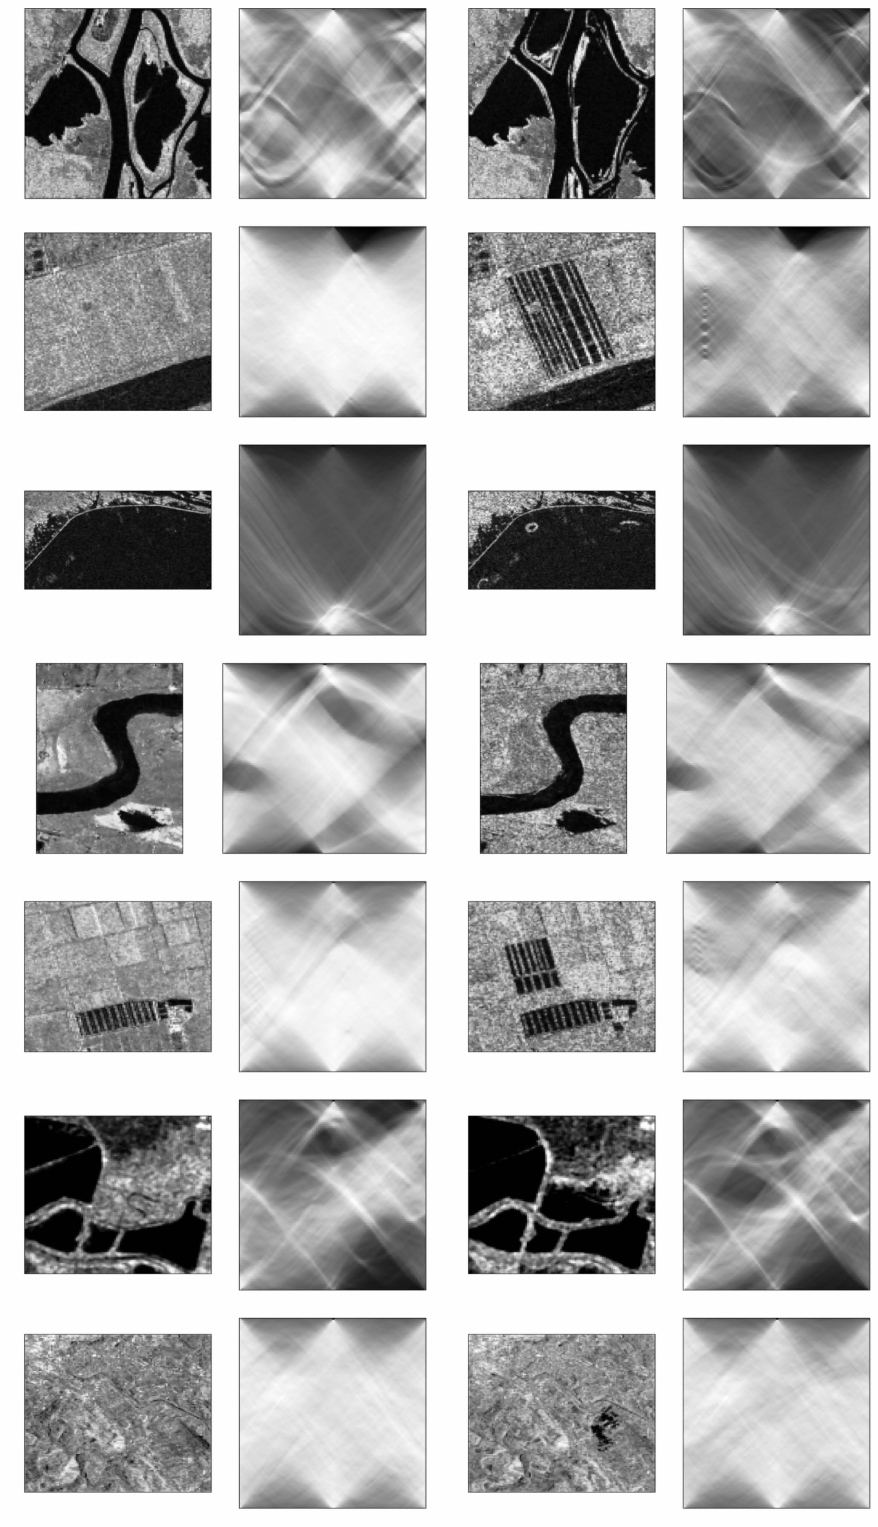
Figure 3. Image pairs and their Radon